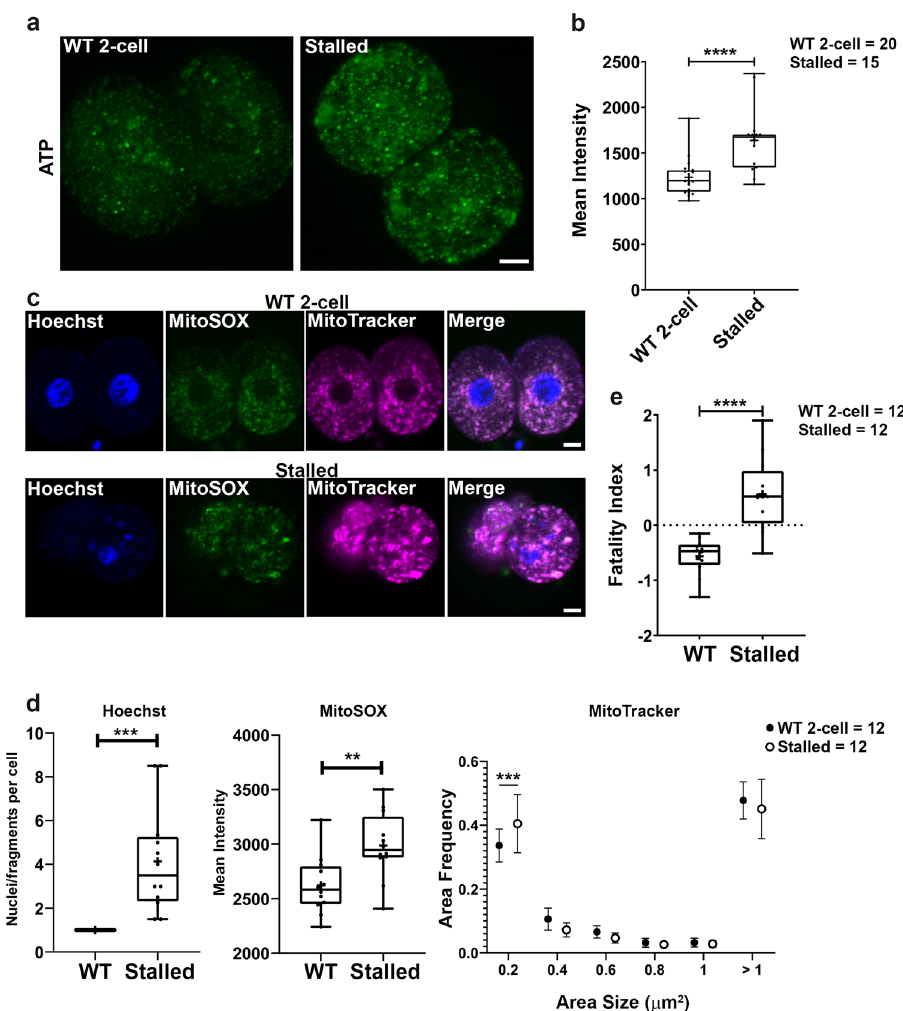
Fig. 6 Loss of Ddx1 leads to higher ATP levels and a higher fatality index. One-cell embryos from Ddx1 heterozygote crosses were cultured for 72 h. One- cell embryos from Ddx1 wild-type crosses cultured to the 2-cell stage were used for comparison. a BioTracker ATP-red staining (green) of stalled 2-cell embryos show higher ATP levels compared to wild-type 2-cell embryos. Maximum intensity projections of the Z-stack images at each stage are shown. b Statistical analysis of ( a ) using Z-stack images for each embryo. Mean intensity values were plotted with Prism. Statistical analysis was performed with two-sided Students ’ t -test. ***indicates p < 0.001 (with the exact p = 1.34E-04). Center line, median; box limits, 25th and 75th percentiles; whiskers, minimum to maximum. Error bars represent standard deviation. c Triple staining of nuclei (Hoechst 33342) (blue), mtROS (MitoSOX) (green) and mitochondria (MitoTracker) (magenta) in stalled versus wild-type two-cell embryos. d Stalled embryos have higher mtROS and more fragmented nuclei and mitochondria based on statistical analysis of each channel in ( c ) plotted individually. Statistical analysis was performed with either two-sided Students ’ t -test or two-sided multiple t -test using the Holm-Sidak method, with alpha = 0.05. ***indicates p < 0.001. **indicates p < 0.01. Exact p value for left panel is 0.0002, center panel is 0.0045, and right panel is 0.00045. For the box plots, center line, median; box limits, 25th and 75th percentiles; whiskers, minimum to maximum. Error bars represent standard deviation. For the symbol plot, each circle represents the mean value, and the error bars represent standard deviation. Solid circles represent wild-type controls; empty circles represent stalled embryos. e Statistical analysis of fatality index constructed with weighted average index construction using the z -scores of nuclei (or nuclei fragments) number/cell, MitoSOX intensity and percentage of mitochondria with size <0.2 µ m 2 , and plotted with Prism. Statistical analysis was performed with two-sided Students ’ t -test. ****indicates p < 0.0001 (with the exact p = 2.66E-05). Center line, median; box limits, 25th and 75th percentiles; whiskers, minimum to maximum. Error bars represent standard deviation. Scale bars = 10 µ m. Numbers of embryos analysed are indicated on the right hand side. WT = wild-type. Z-stack images were used for statistical analysis of nuclei and mtROS whereas single plane images of each embryo (middle sections) were used for statistical analysis of